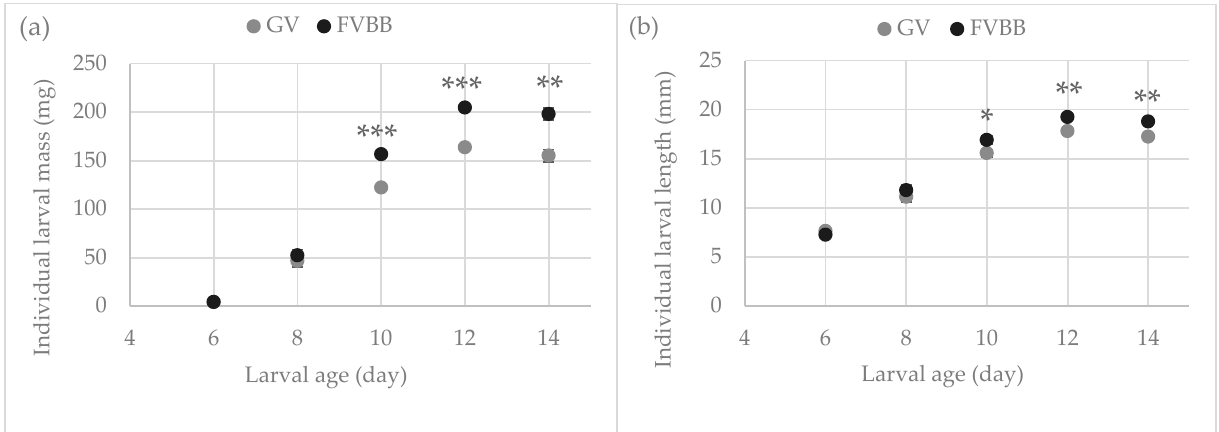
Figure 1. BSFL development: ( a ) Individual larval mass; ( b ) individual larval length. GV = Gainesville and FVBB = fruit/vegetable/bakery/brewery diets. p -value: * = p < 0.05, ** = p < 0.01, *** = p < 0.001. Error bars represent the standard error of the mean (n = 3).